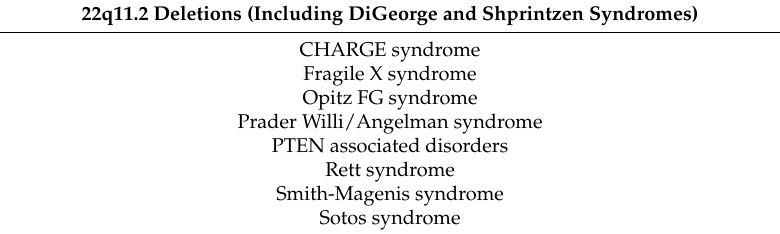
Table 3. Important Dysmorphic Syndromes to Consider in the Etiologic Evaluation of ASD.